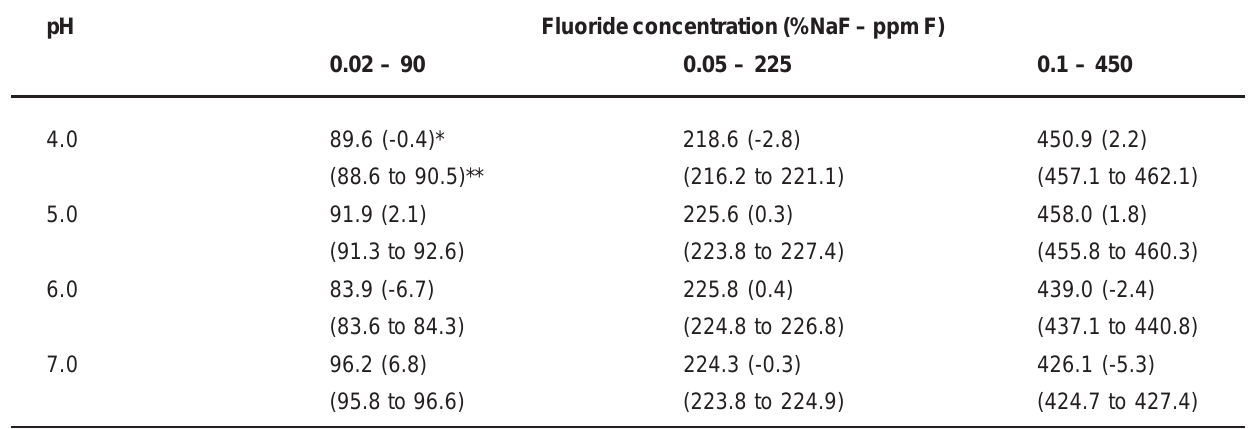
* percentage of the variation coefficient ; ** confidence interval (95%).